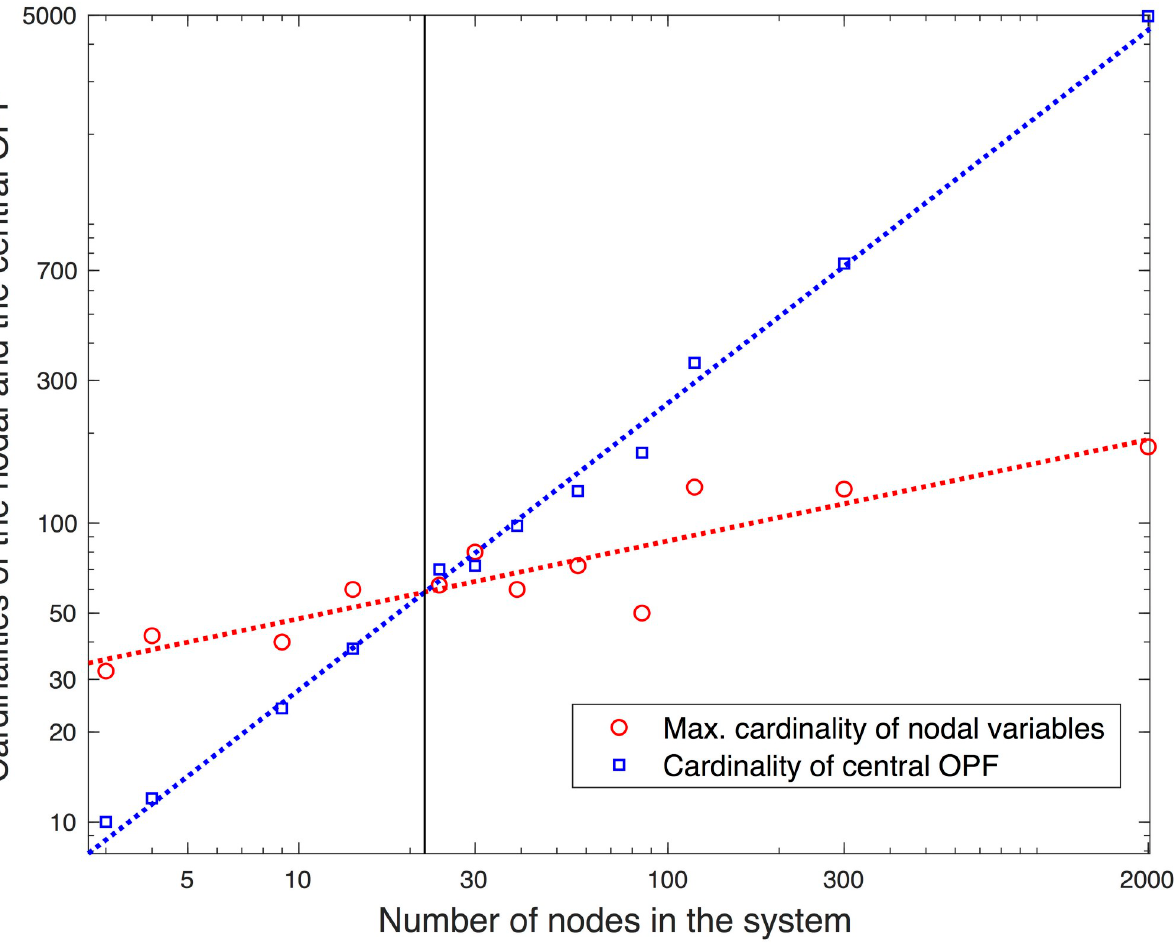
Fig 9. Cardinalities of central OPF and proposed algorithm for the test systems.